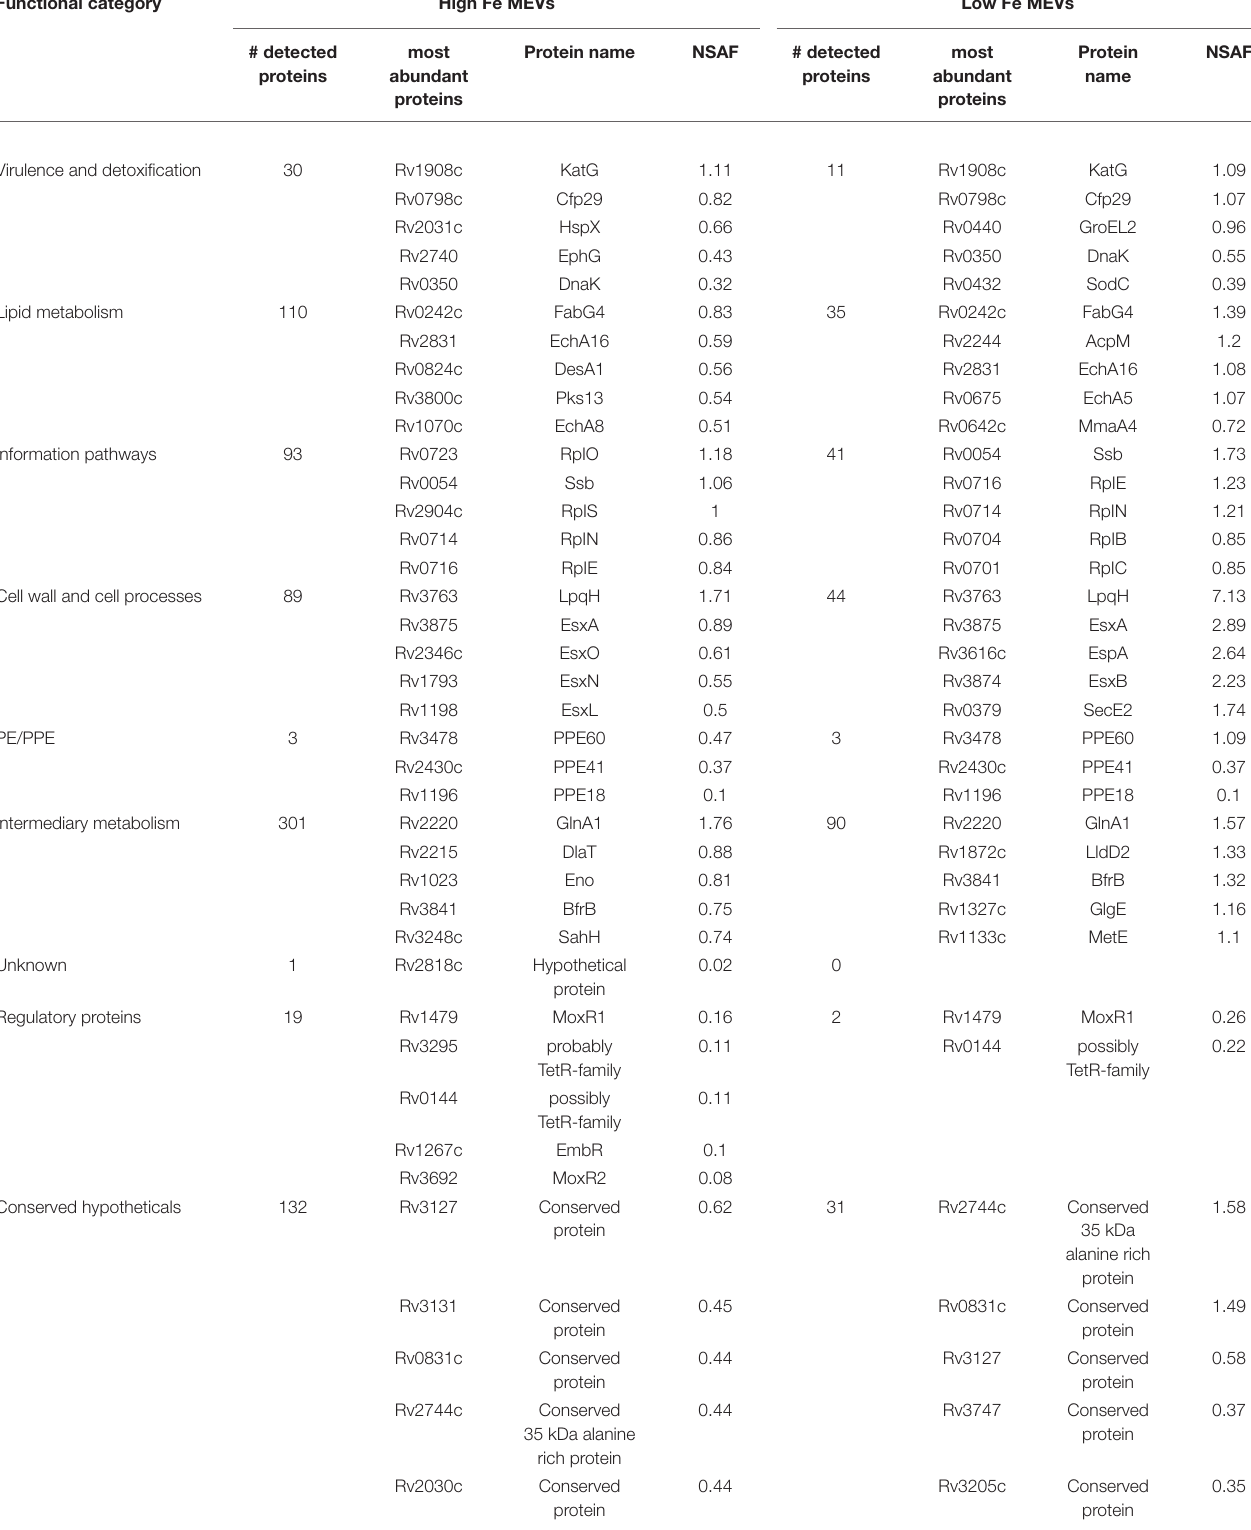
TABLE 1 | Most abundant proteins in High Fe and Low Fe